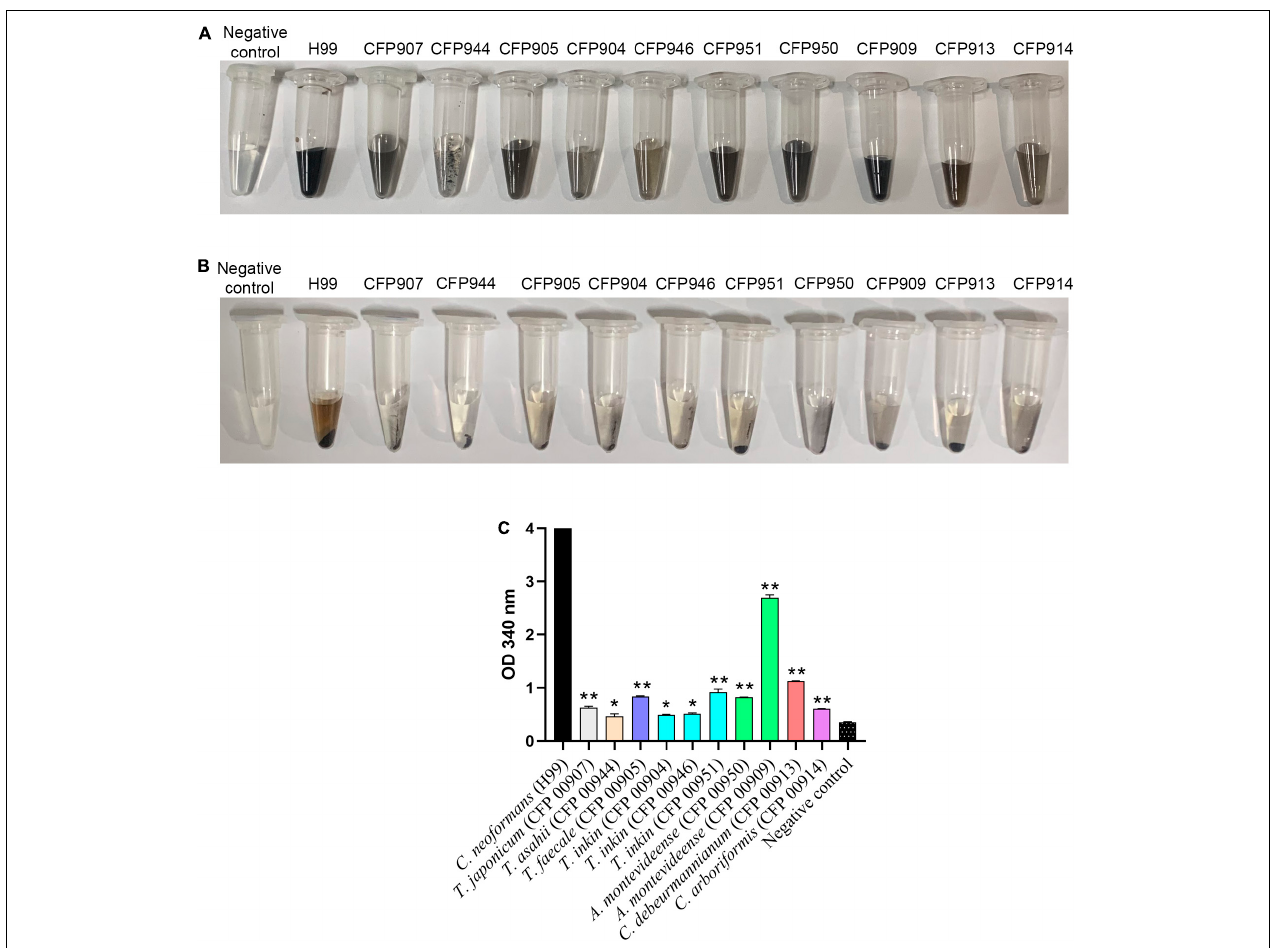
FIGURE 1 | Production of melanin by 10 different Trichosporonaceae strains in the presence of L-DOPA. Each tube contains melanin ghosts of each strain cultured for 14 days with 1 mM L-DOPA. The H99 Cryptococcus neoformans strain was used as a positive control and minimal medium with 1 mM D-DOPA without cells as a negative control. (A) Vortex homogenized melanin particles. (B) Pellet of melanin particles. (C) Quantification of melanin by spectrophotometry. *Indicates a statistical difference when compared only with the Cryptococcus neoformans H99 melanin control. **Indicates a statistical difference when compared with the Trichosporon asahii and Cryptococcus neoformans grubii H99 melanin.